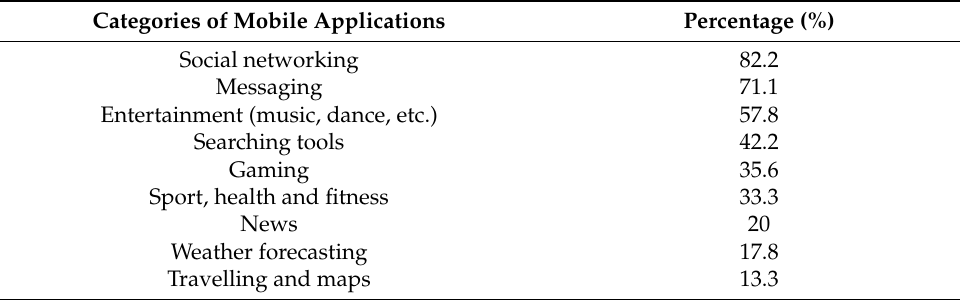
Table 2. Mobile applications that pupils use the most.